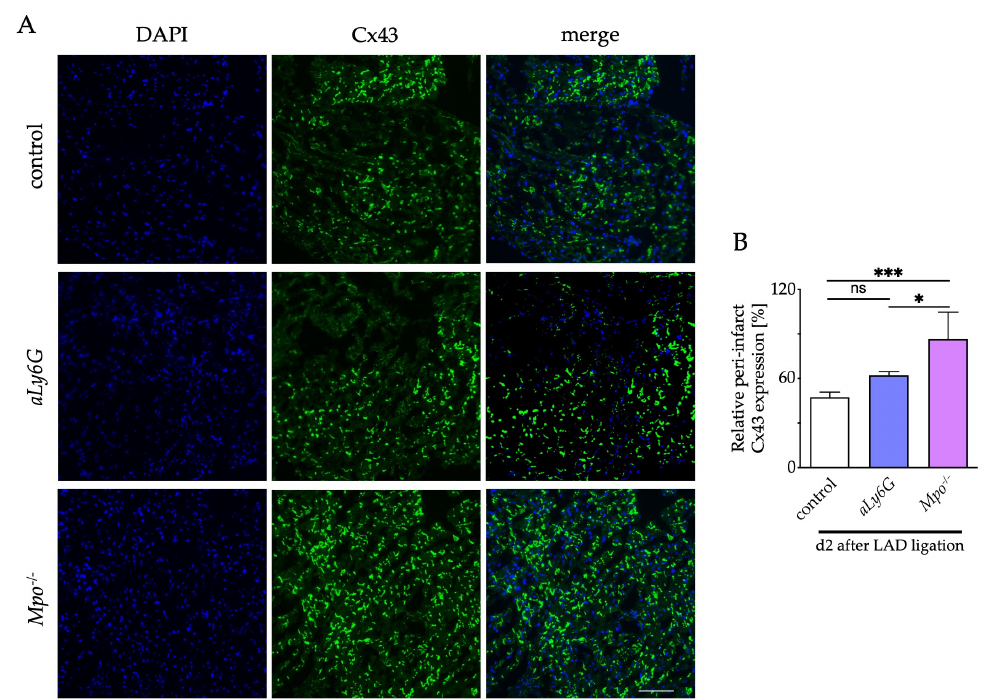
Fig 5 Figure 5. Connexin 43 (Cx43) expression in peri-infarct region. ( A ) Representative immunofluores- cence stainings of murine cardiac sections after 2 days of PI for Cx43 (green = Cx43, blue = DAPI; scale bar = 50 µ m). ( B ) Quantitative analysis of relative Cx43 expression within the peri-infarct region compared with healthy myocardium. n = 6/4/5; * p < 0.05, *** p < 0.001, ns = not significant; one way ANOVA test followed by appropriate post hoc test, mean ± SEM is